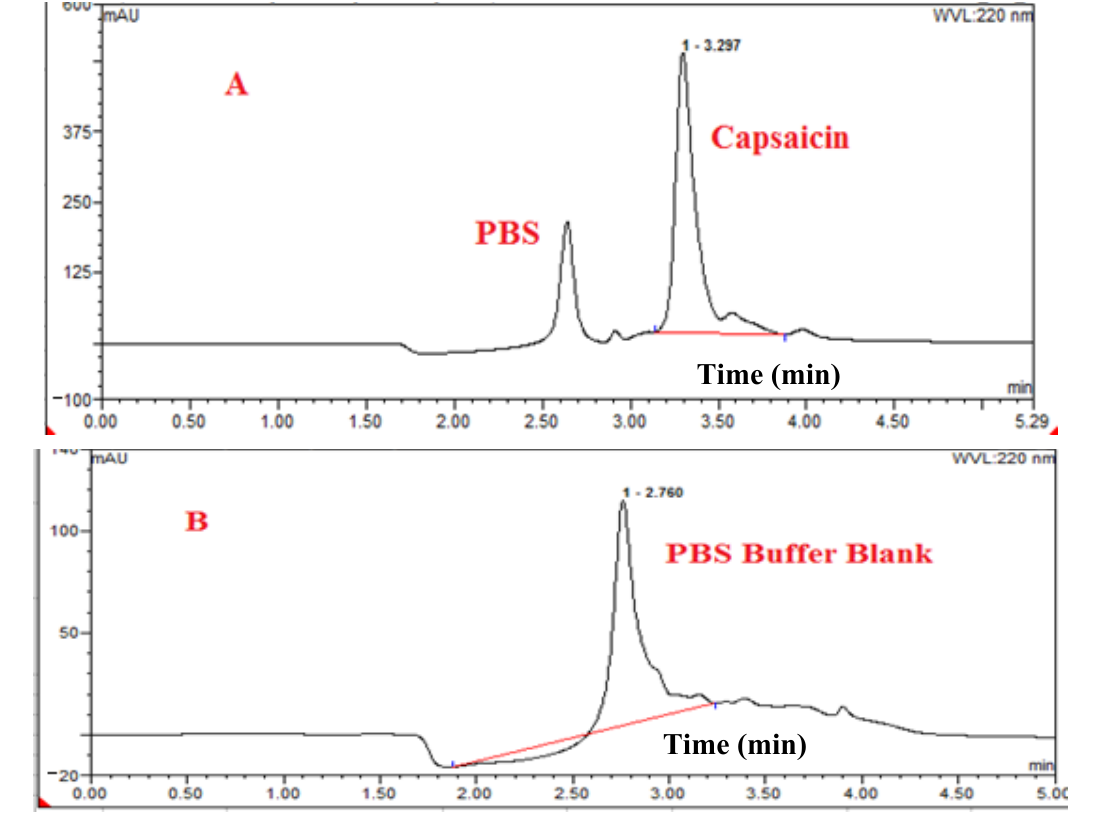
Figure 1. HPLC spectrum of ( A ): CAP loaded inside nanoliposomes, ( B ): PBS buffer blank hydration media.